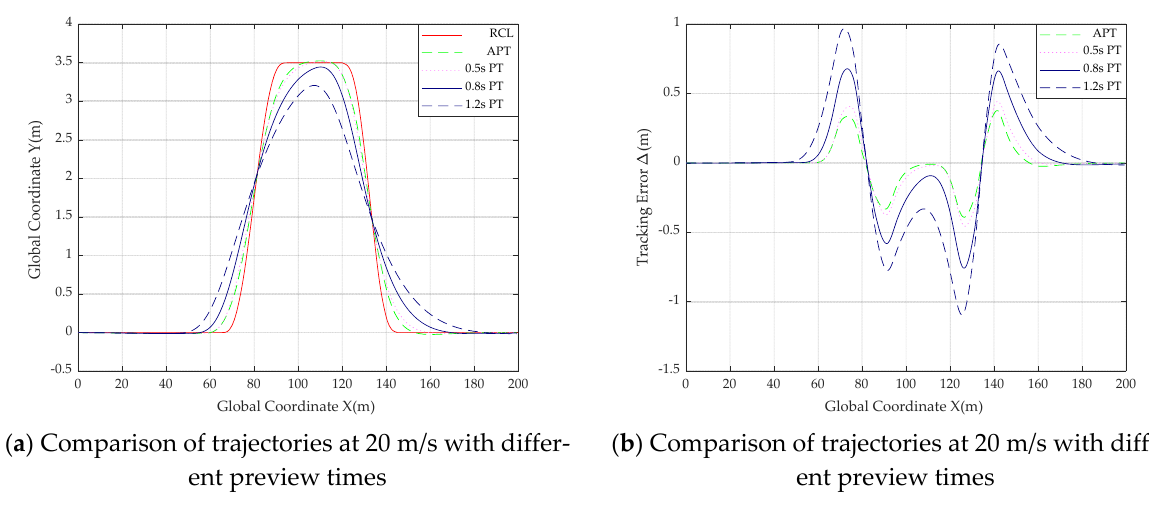
( b ) Comparison of trajectories at 15 m/s with differ ‐ Figure 14. Comparison of trajectories and tracking error with different preview times at 15 m/s.